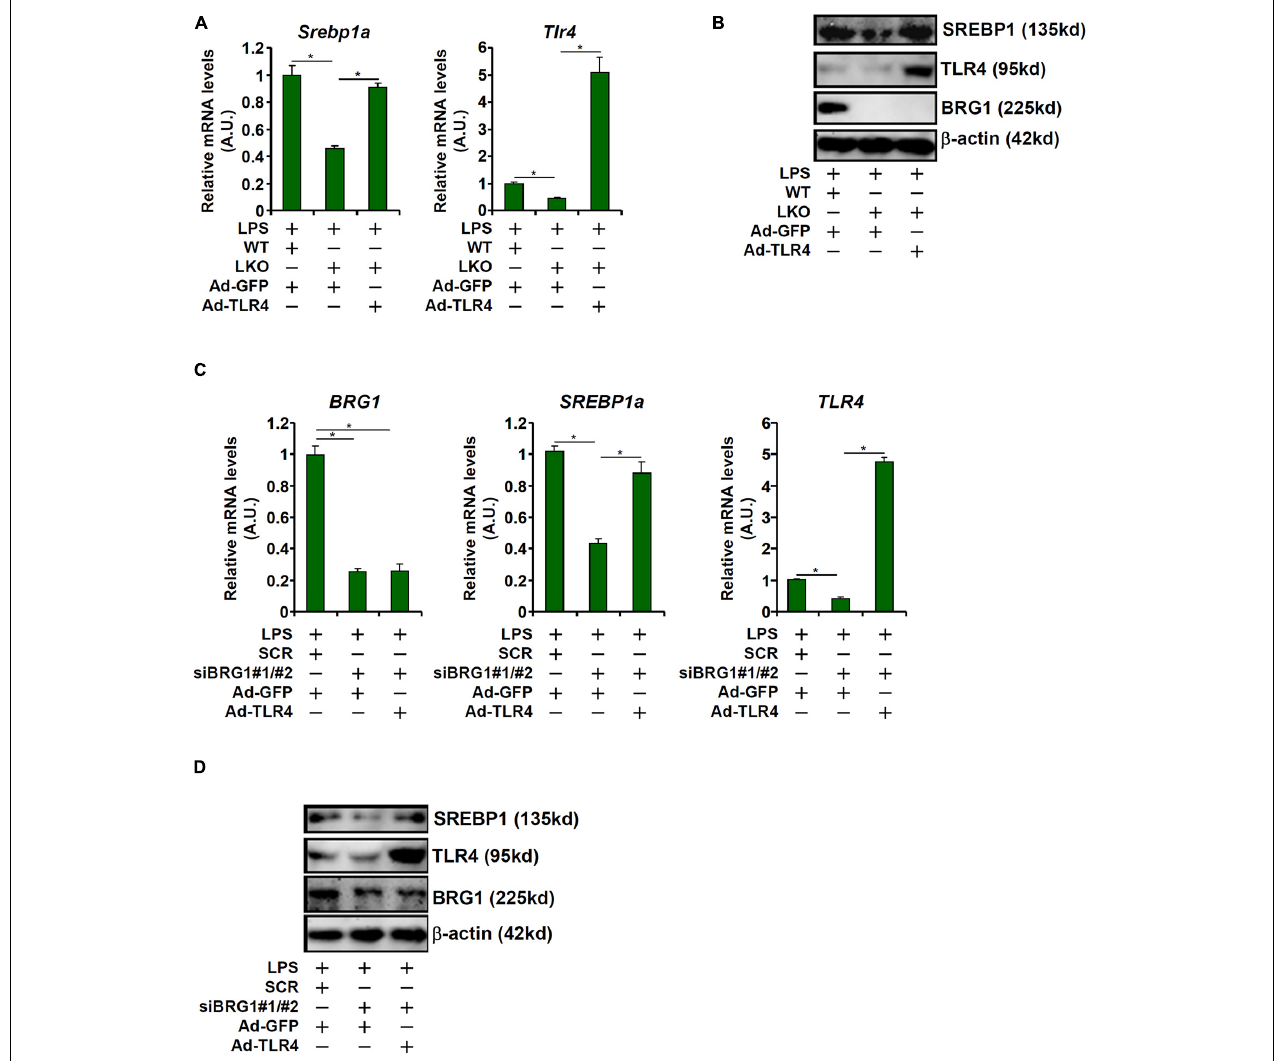
FIGURE 4 | TLR4 over-expression rescues SREBP1a induction by LPS in hepatocytes. (A,B) Primary hepatocytes isolated from WT and BRG1 LKO mice were infected with adenovirus carrying either TLR4 (Ad-TLR4) or GFP (Ad-GFP) followed by treatment with LPS (1 µ g/ml) for 12 h. SREBP1a expression was examined by qPCR and Western. (C,D) HepG2 cells were transfected with siRNA targeting BRG1 or scrambled siRNA (SCR) followed by infection with Ad-GFP-TLR4 or Ad-GFP and treatment with LPS (1 µ g/ml) for 12 h and SREBP1a expression was examined by qPCR and